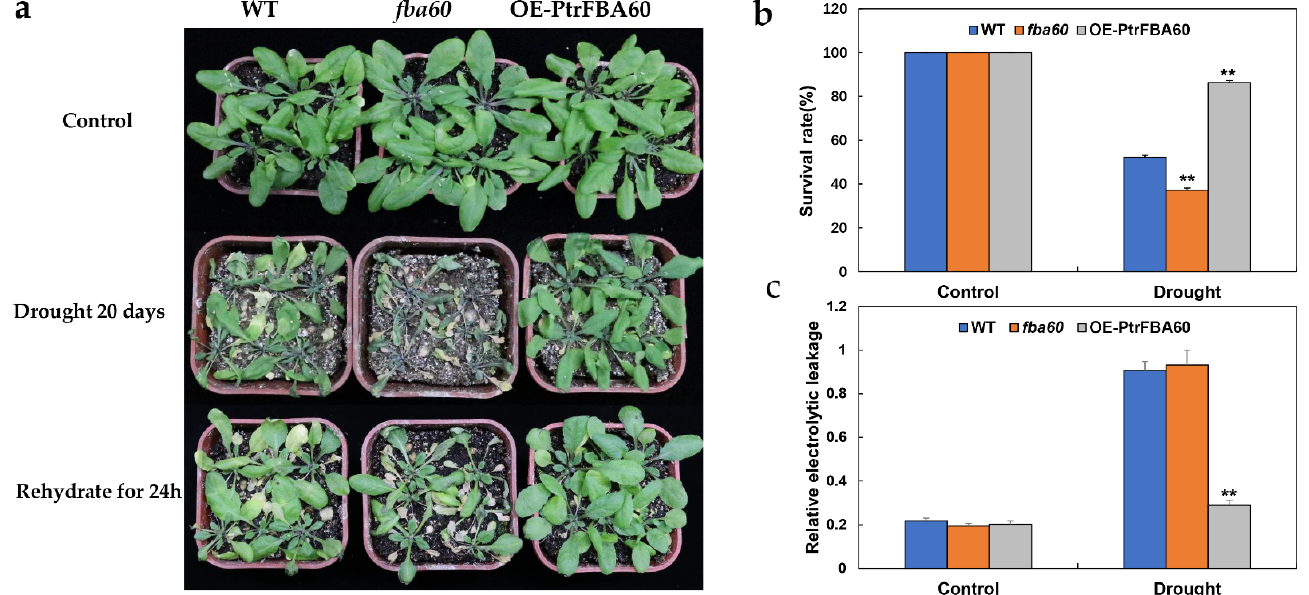
Figure 11. Drought stress treatment in transgenic Arabidopsis thaliana. ( a ) The phenotypes of wild- type Arabidopsis thaliana (WT), mutant fba60 and OE-PtrFBA60 after drought and being rewatered. ( b ) The survival rate of each line after drought treatment. ( c ) REC of each line after drought treatment. Values shown are averages ± SE from three replicates (n = 50 in each replicate). ** p < 0.01 (Student’s t test) with respect to the wild type values in the same experimental conditions.